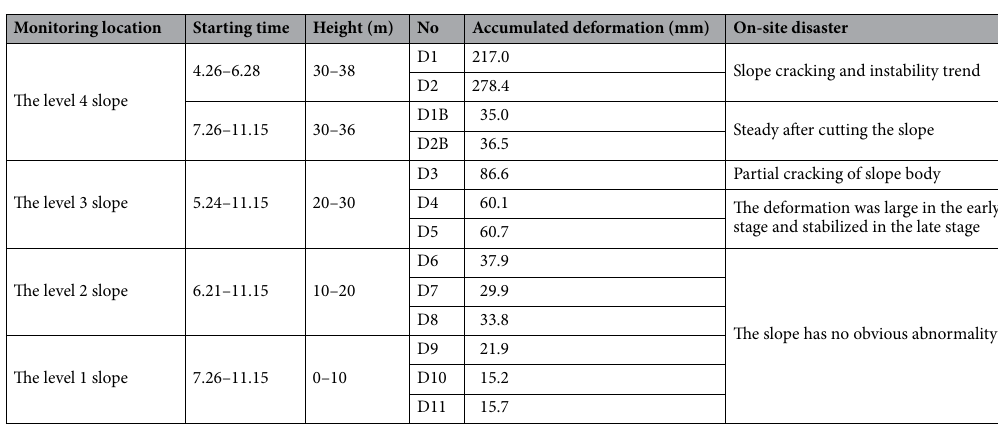
Table 2. Cumulative deformation and on-site disaster of Damao slope.